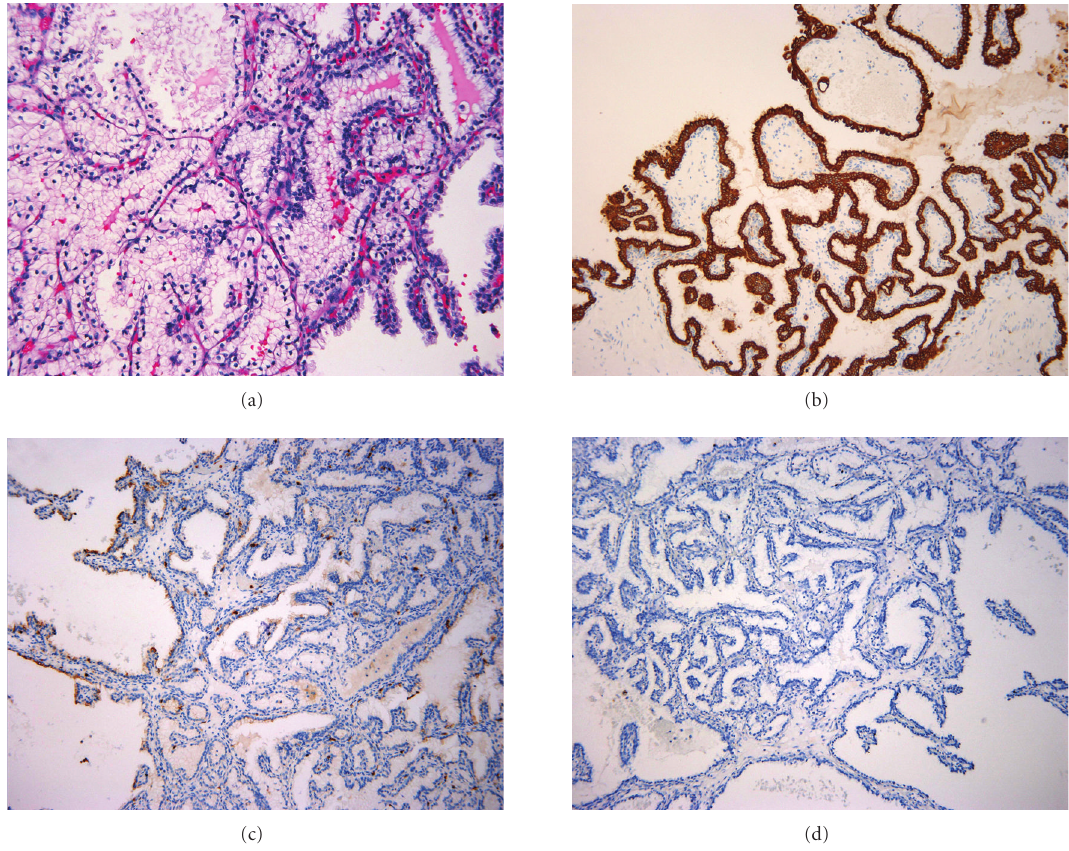
Figure 1: Clear cell papillary renal cell carcinoma in native kidneys of a renal transplant recipient. (a) Single layers of clear cells with moderate amount of clear cytoplasm and pyknotic nuclei oriented toward the apical surfaces, H&E 400 × ; (b) di ff use CK7 positivity, 100 × ; (c) weak CD10 stain, 100 × ; (d) negative RCC stain, 100 ×